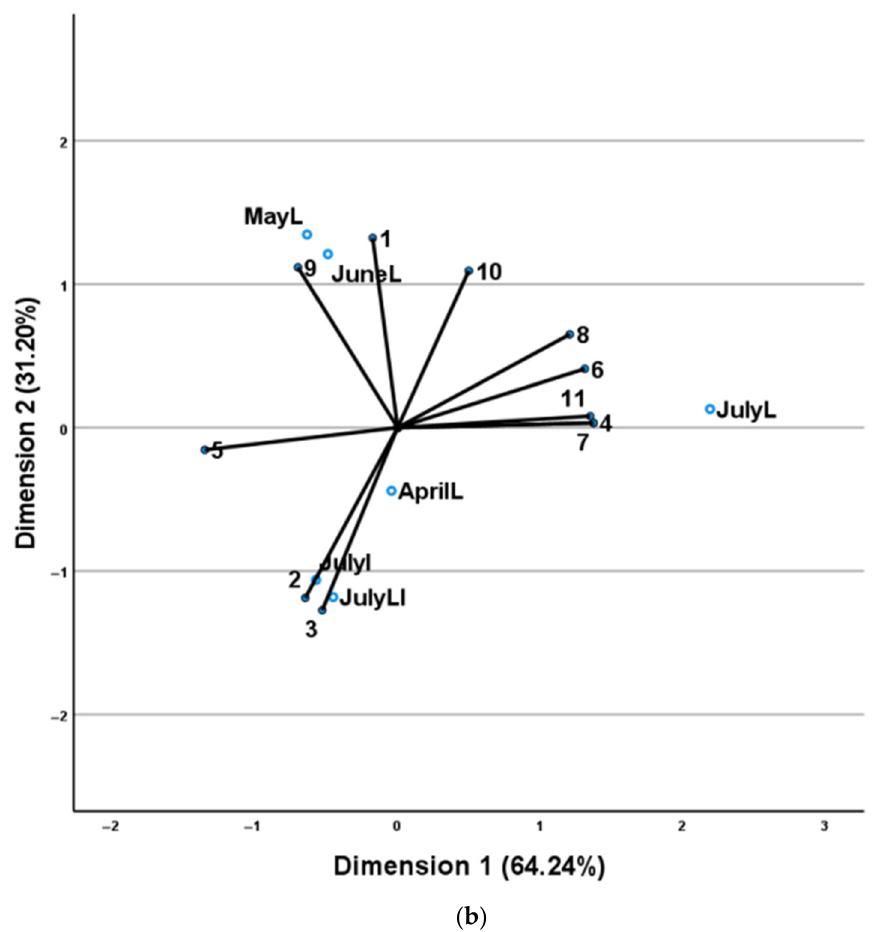
Figure 6. ( a ) CATPCA analyses of chemical composition of O. vulgare subsp. hirtum leaf (L), inflorescences (I) and leaf-inflorescence (LI) oils, for samples collected ( a ) from the field (OVHF). ( b ) From the greenhouse (OVHG). Distribution of variables (component codes corresponding to those of Tables 5 and 6) determined the distribution of samples.